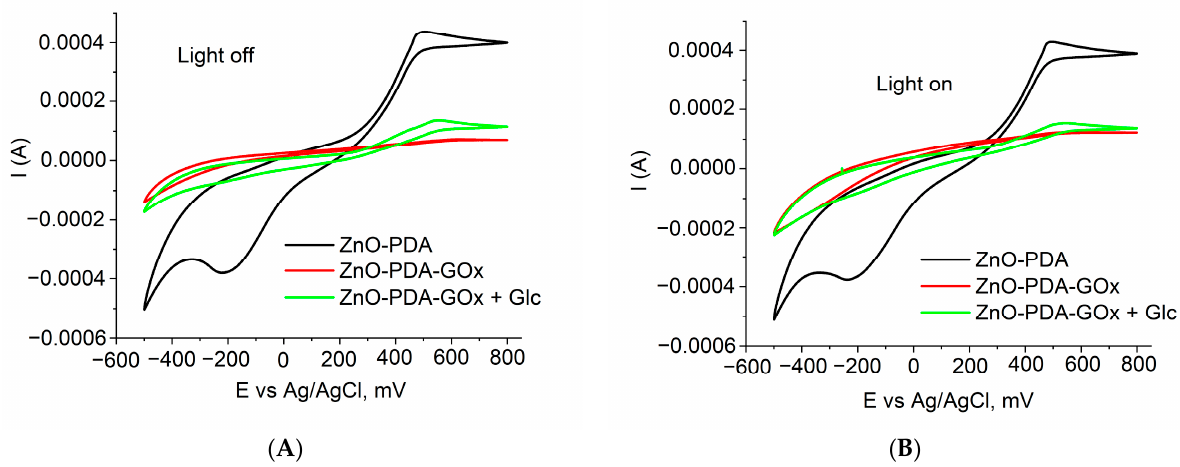
Figure 2. Cyclic voltammograms of glass/ITO/ZnO and glass/ITO/ZnO-PDA/GOx electrodes in the absence of glucose and glass/ITO/ZnO-PDA/GOx in the presence of 0.08 mM of glucose: ( A ) C–V measurements in ‘dark’ conditions; ( B ) C–V measurements in under UV excitation.